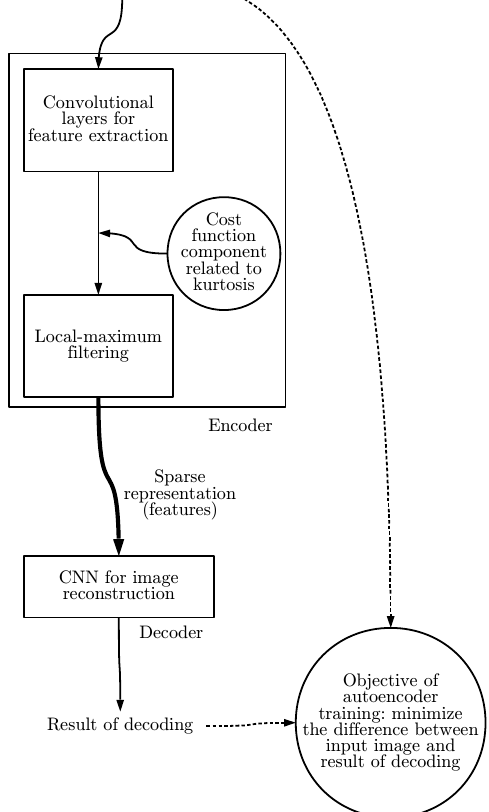
Figure 2. The full architecture of the autoencoder consists of two major parts: encoder and decoder. The encoder includes convolutional layers that can either be adjusted to the data set in the learning process or use some fixed weights. The result is further processed with local-maximum filtering (Section 3.3). In the case of adjustable convolutional layers in the encoder, the cost function related to the encoder’s CNN output is modified in order to reduce the output kurtosis, as described in Section 3.2. The encoder output is fed into the decoder which consists of convolutional layers that participate in the learning process. The learning objective is to reproduce the original input image, while minimizing the reconstruction error, which is measured in terms of the Euclidean